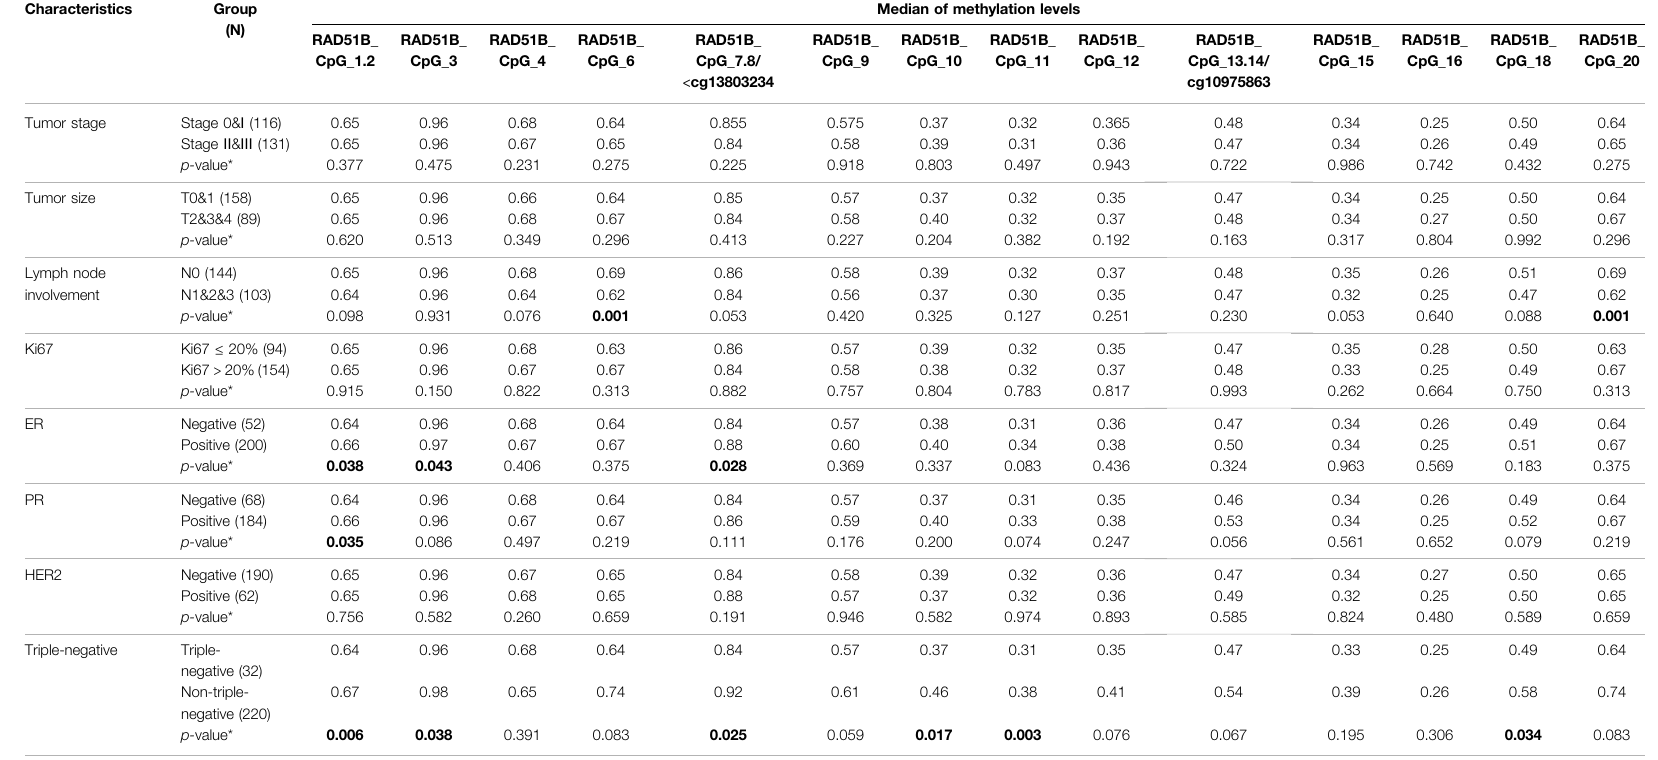
*Mann-Whitney U test. Bold values indicated p <